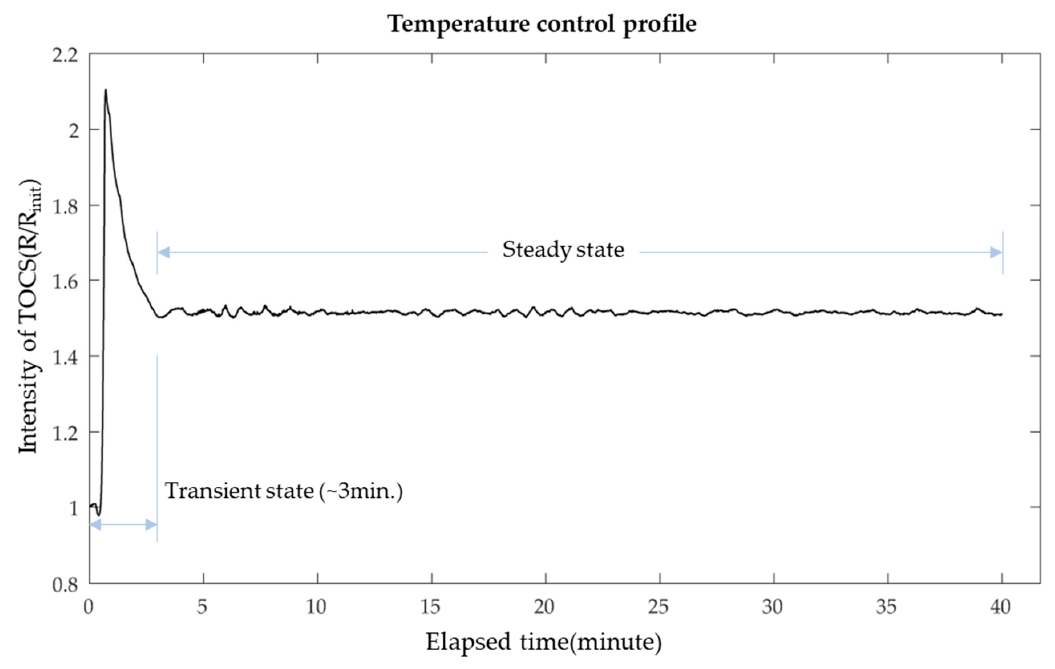
Figure 6. Experimental results obtained for the temperature control profile.